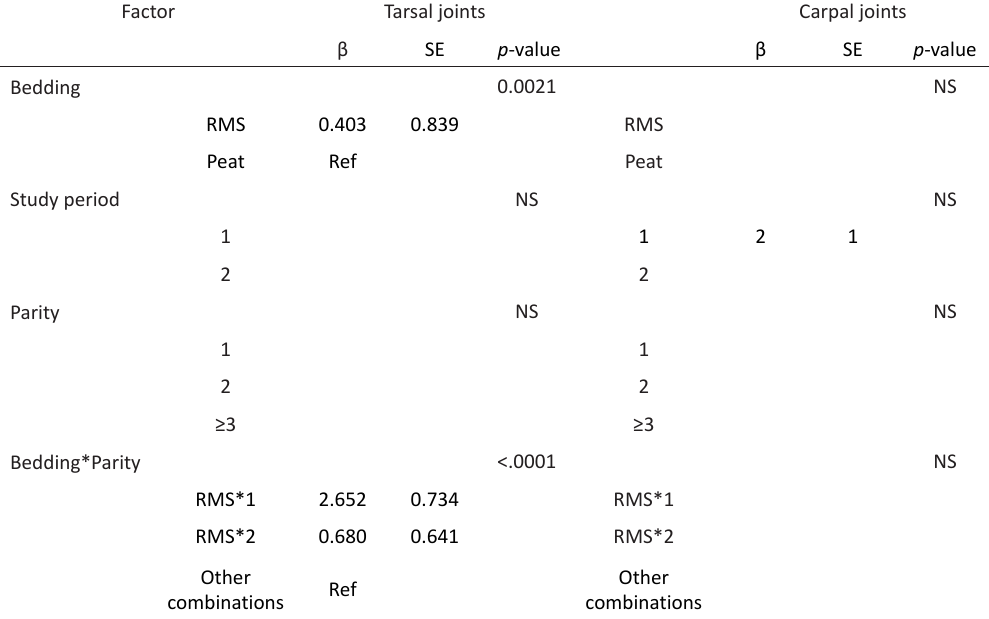
Table 4. Model estimates describing the factors influencing the integument alteration of the cows with β, standard error (SE) and significant p -values. For the interactions only estimates from the significant pairs are presented. The